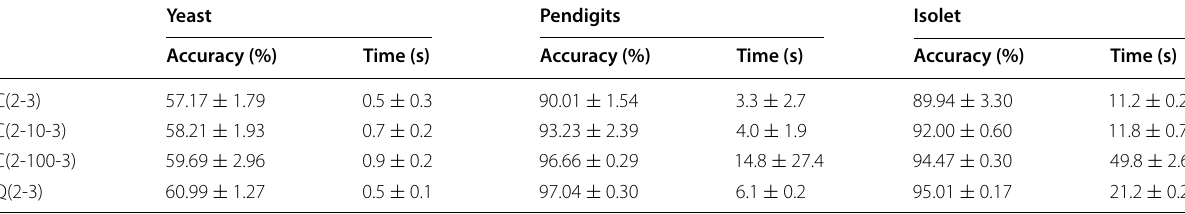
Table 4 The average accuracy of and time needed by Q and C neural networks with different numbers of neurons for three real datasets. The notation ( · ) stands for the architecture of a neural network as described in Eq.